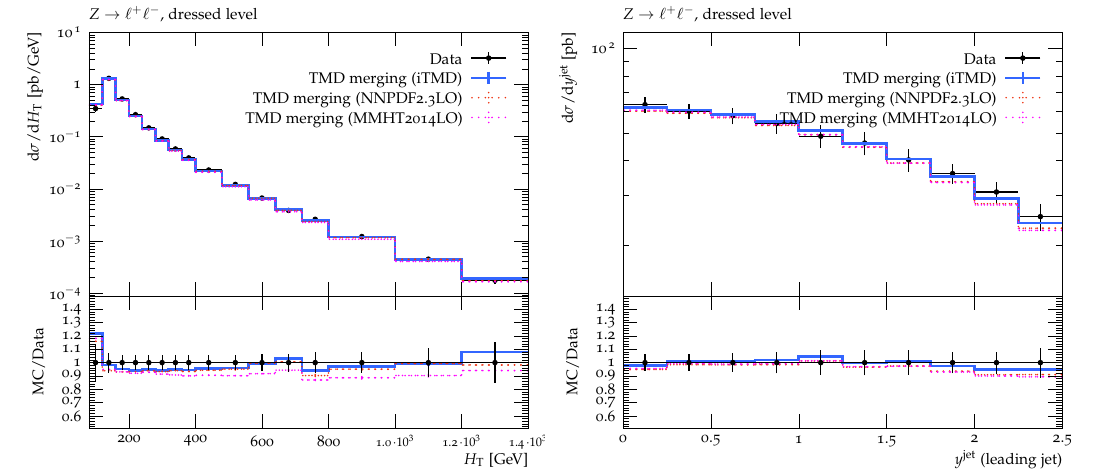
Figure 37 . Scalar sum H T of the transverse momenta of leptons and jets (left), and leading jet rapidity (right) distributions for Z + jets events: PDF